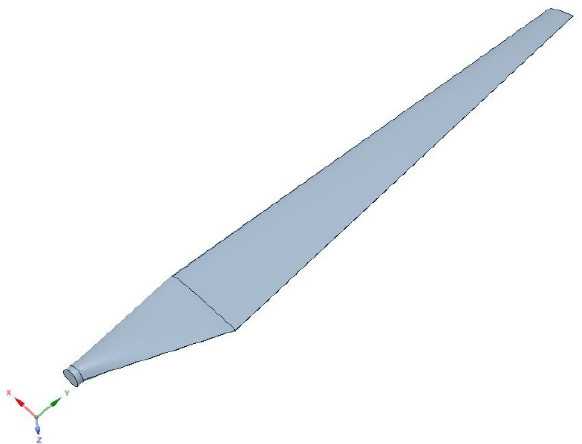
Figure 3. Three-dimensional (3D) geometry of the rotor blade.